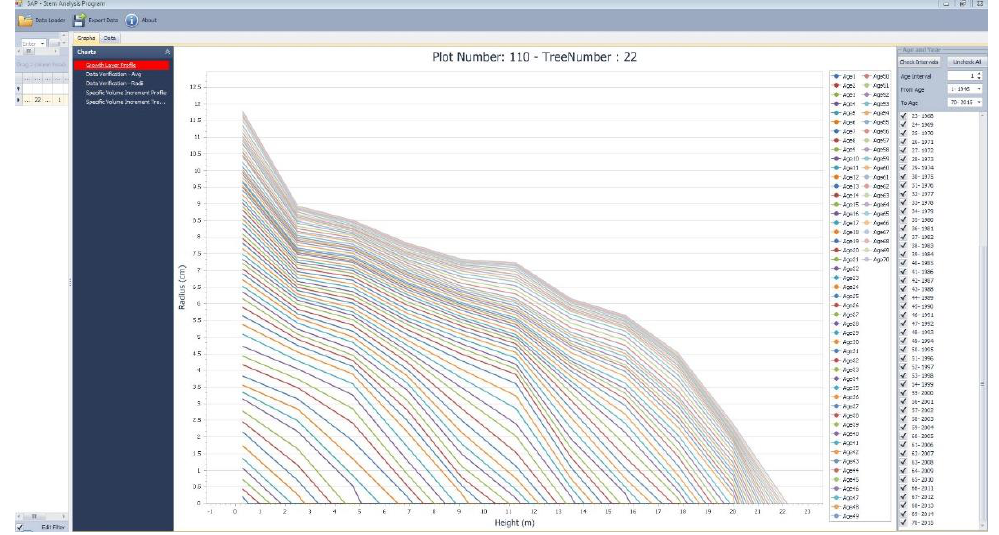
Figure 3. Screenshot of the output graphic list under the “Graphs” tool bar with the annual growth layer profiles displayed by year selected for the example tree.